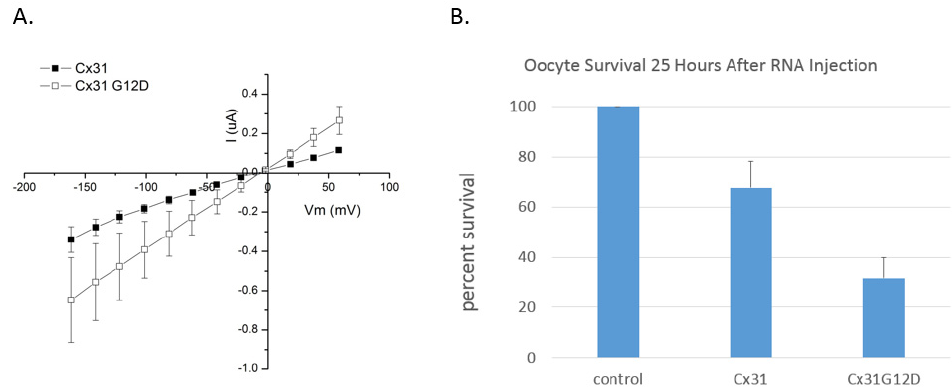
Figure 5. ( A ) Cx31G12D induces membrane currents in Xenopus oocytes. Current versus voltage plots for Cx31G12D and wildtype Cx31 demonstrate that the mutant G12D increases membrane permeability. Currents were induced by 20 mV voltage pulses from a holding potential of − 20 mV, n = 3. Image from [76] Bailey, 2020. ( B ) Cx31G12D induces cell death in single oocytes. Oocytes were assessed for survival 25 h after injection of RNA. Those extruding cytoplasm were considered dead. Since there was no apparent effect of divalent cations on cell survival results were pooled revealing that 32% of oocytes expressing Cx31G12D survived compared to 68% of control Cx31-injected oocytes and 100% of oocytes injected with antisense oligonucleotide against XeCx38.